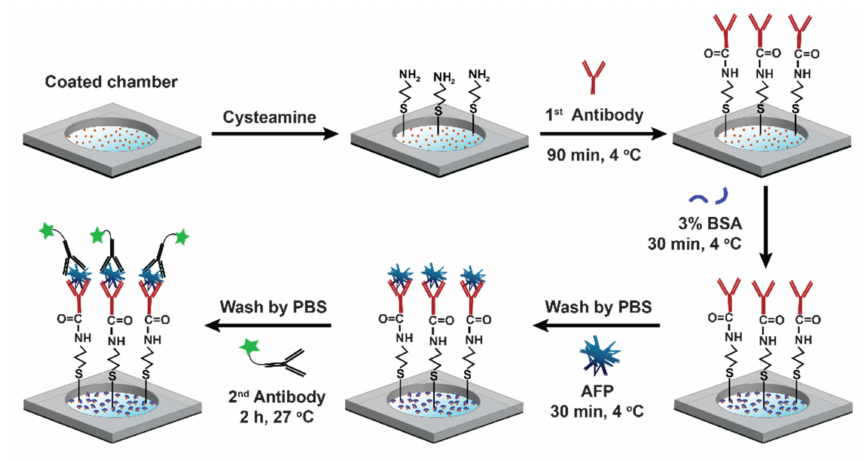
Figure 2. A schematic representation of the AFP immunosensor based on MEF with